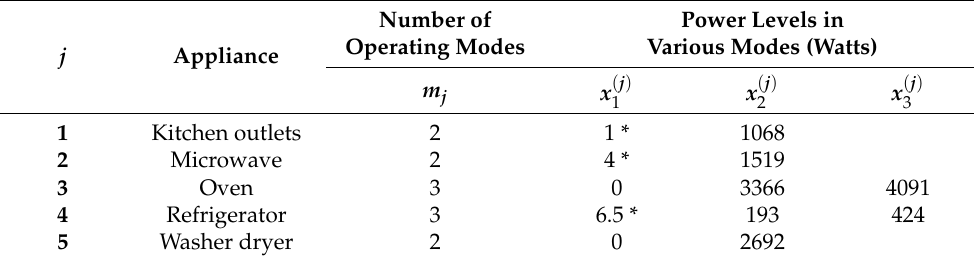
Table 2. States of appliances, computed by K-means clustering.